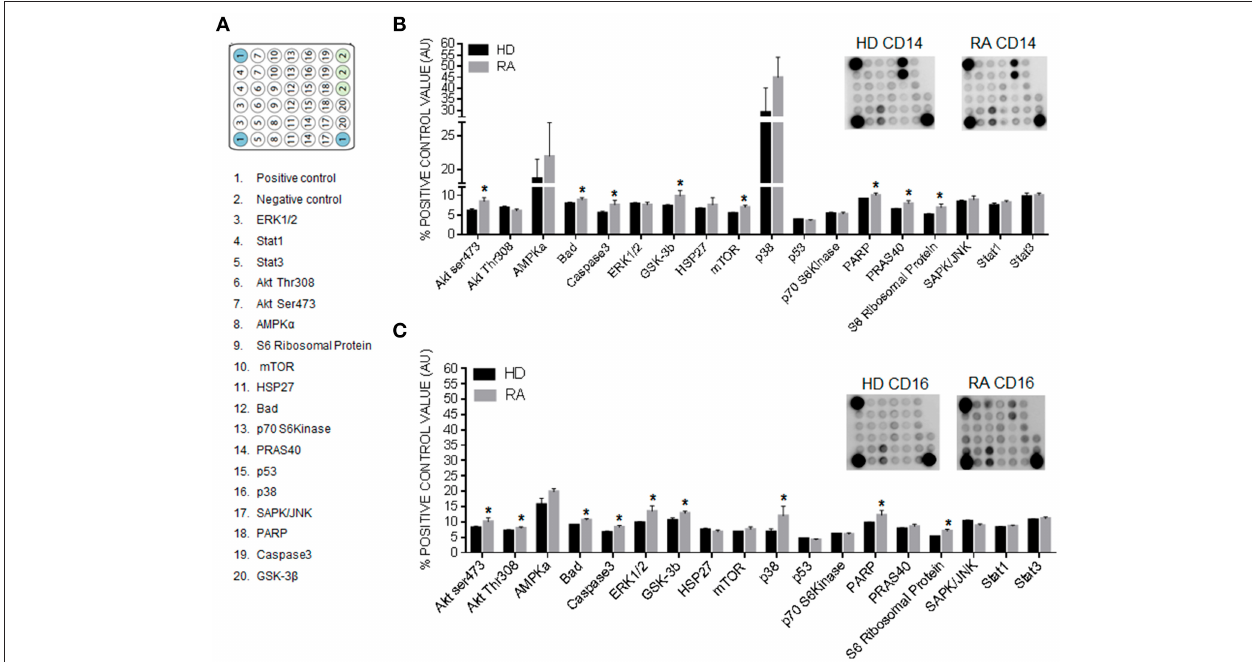
FIGURE 7 | CD14 + and CD16 + monocytes of RA patients displayed a specific and distinctive activation of intracellular kinases. (A) Name and position in the membrane of the kinases analyzed in the PathScan intracellular signaling array. (B) Two representative panels of phosphorylation status of kinases using a PathScan intracellular signaling array in CD14 + monocytes isolated from RA and HDs. Quantification of volume intensity x area (mm2). (C) Two representative panels of phosphorylation status of kinases using a PathScan intracellular signaling array in CD16 + monocytes isolated from RA and HDs. Quantification of volume intensity x area (mm2). Data are presented as mean ± SD, n = 50 RA patients and 33 HDs. Paired t -test was performed *indicates significant differences vs. HDs ( p <